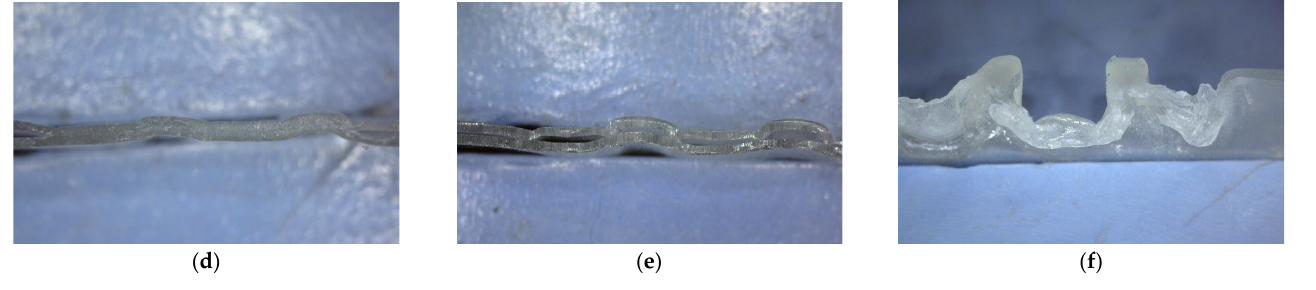
Figure 7. The visual appearance of a weld with a nice appearance ( a ) and its cross-sectional view ( d ), weld with scarcely noticeable damage symptoms ( b ) and its cross-sectional view ( e ), weld with substantial weld damage ( c ) and and its cross-sectional view ( f ).